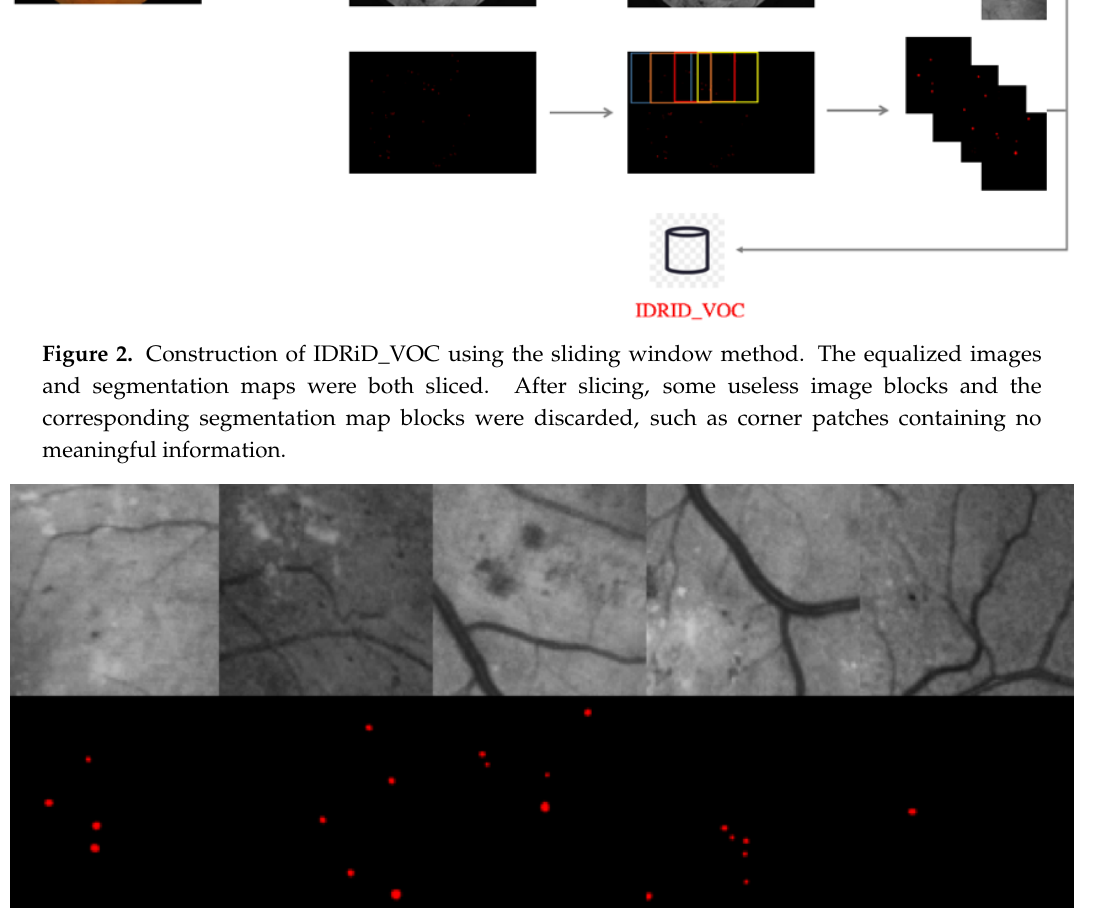
Figure 3. Image blocks and MA segmentation maps. After image preprocessing, each image in IDRiD_VOC contains at least one target MA object, and the dataset includes no large areas of all black